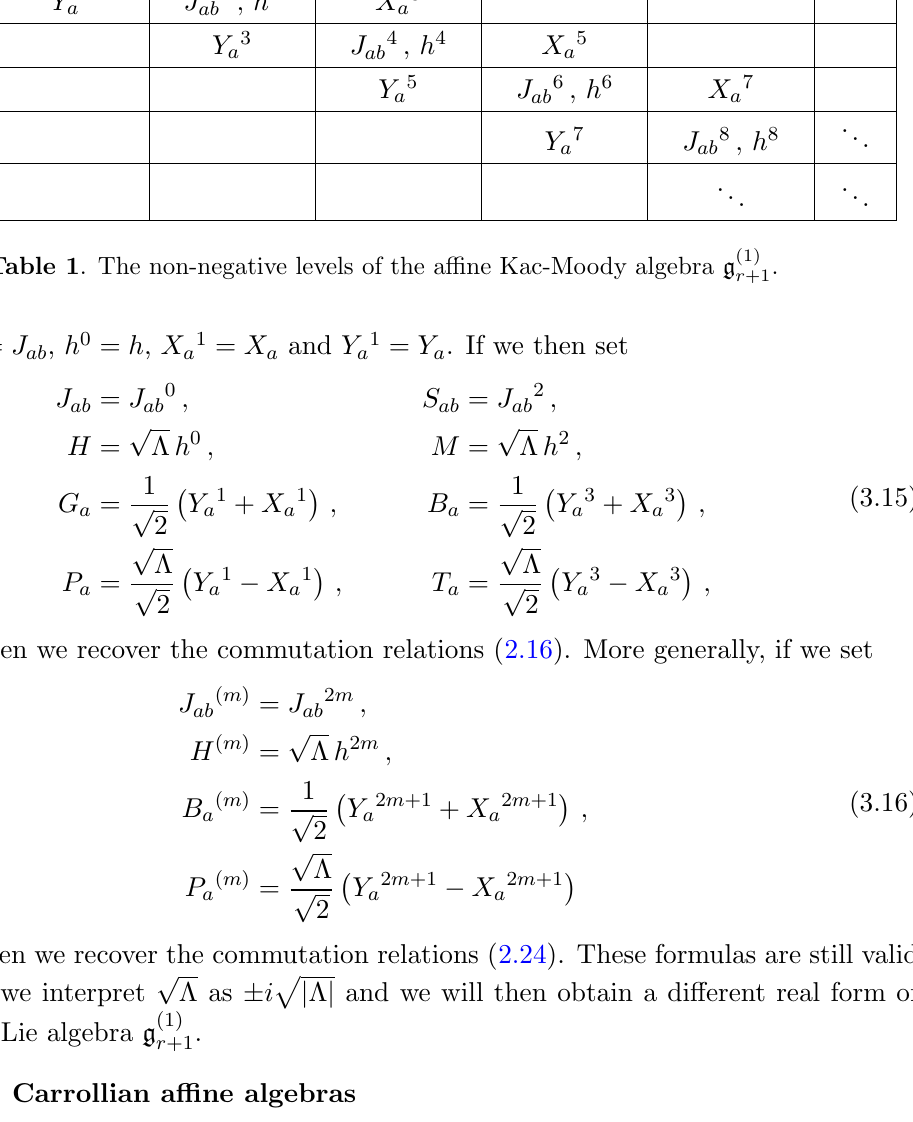
Table 1 . The non-negative levels of the a(cid:14)ne Kac-Moody algebra g (1)